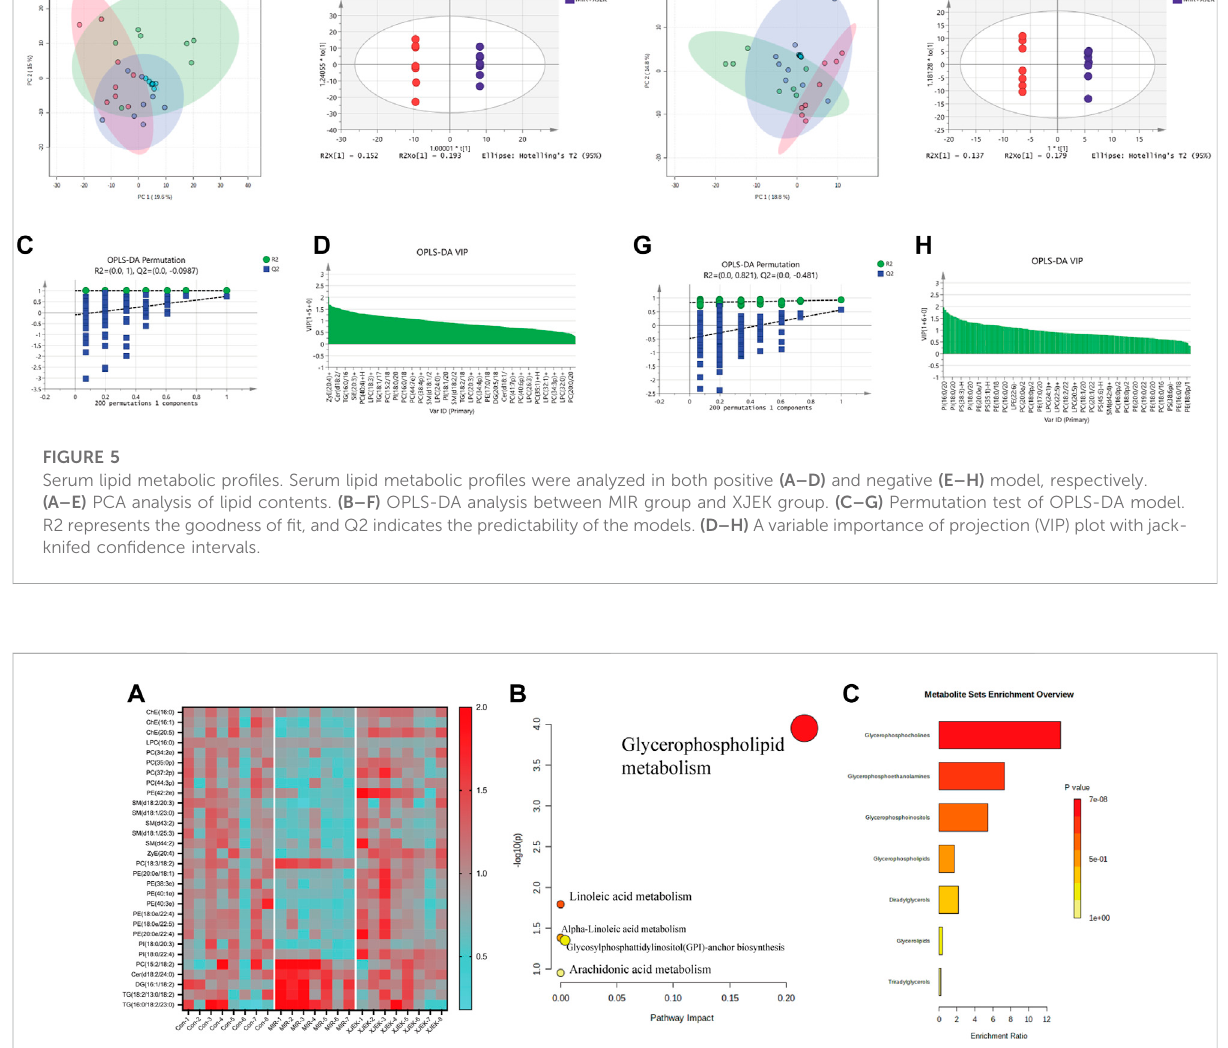
FIGURE 6 XJEK corrected dysregulated lipid metabolism. (A) Heatmap of hierarchical clustering analysis showing differentially expressed lipids among all the groups. The horizontal axis represents the samples; the vertical axis represents the lipid metabolites. Pathway (B) and enrichment (C) analysis based on differentially expressed lipids by MetaboAnalyst